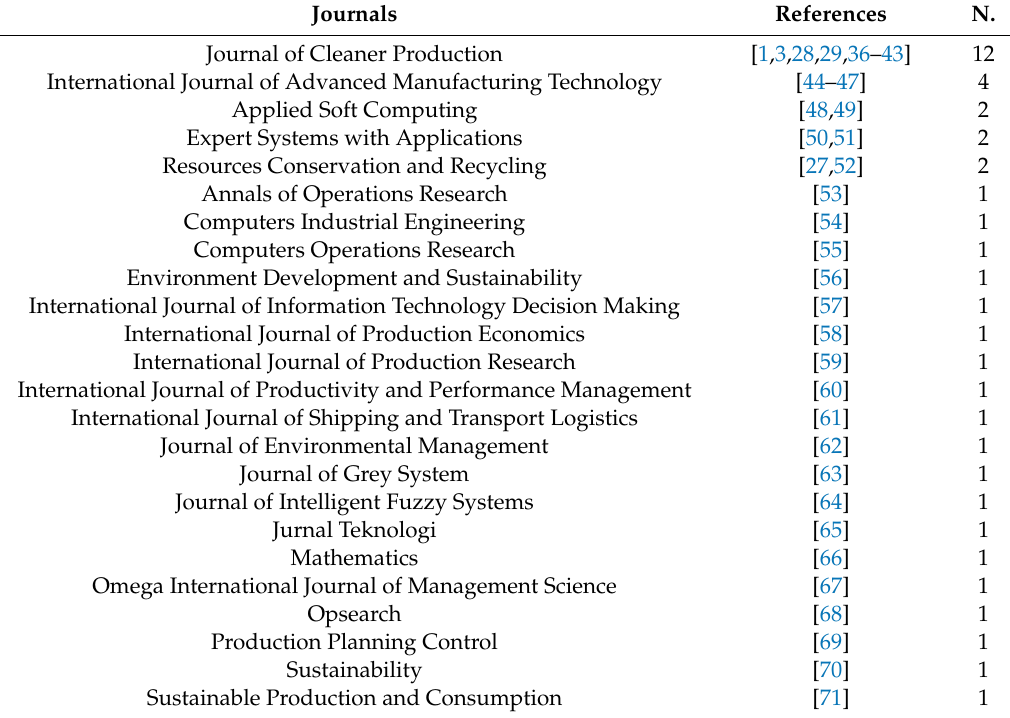
Table 1. List of journals and number of papers.